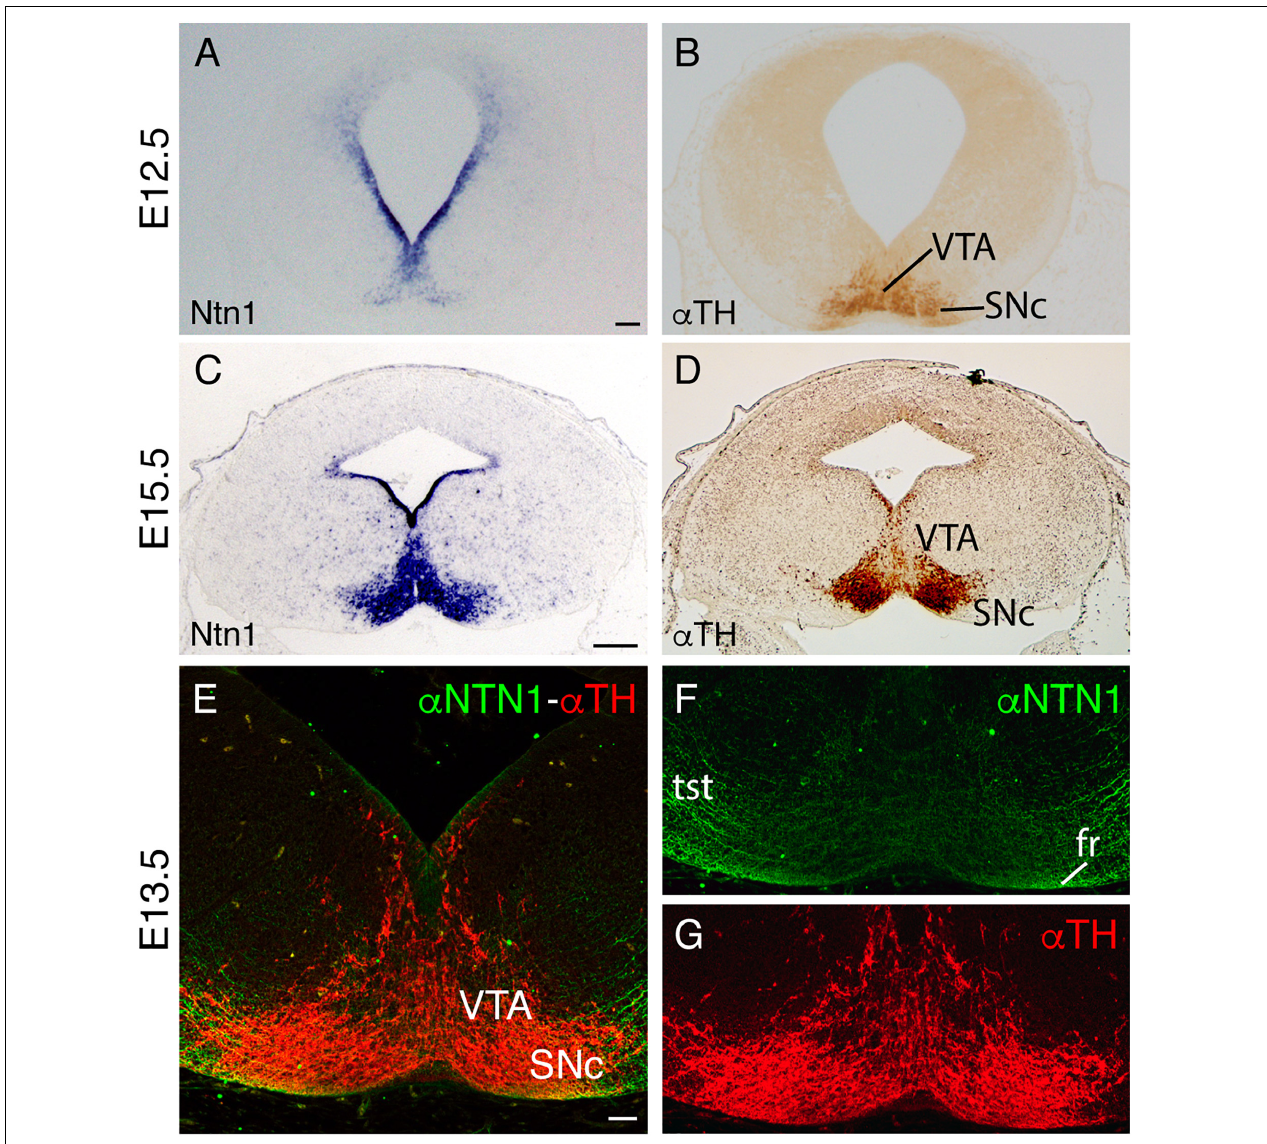
FIGURE 4 | Ntn1 and NTN1 in the SNc and VTA. (A,B) Adjacent coronal paraffin section of a unique E12.5 brain. (A) In situ hybridization for Ntn1. (B) IHC against TH. (C,D) Adjacent coronal paraffin section of a E15.5 brain. (C) In situ hybridization for Ntn1 . (D) IHC against TH. (E–G) Midbrain coronal section of a E13.5 brain with fluorescent immunohistochemistry against NTN1 and TH. Both protein and mRNA are localized in the SNc and VTA. (F,G) are the single channels of (E) . Abbreviations: SNc, substantia nigra pars compacta; fr, fasciculus retroflexus; tst, tectospinal tract; VTA, ventral tegmental area. Scale bar: 200 and 100 µ m in (E–G)